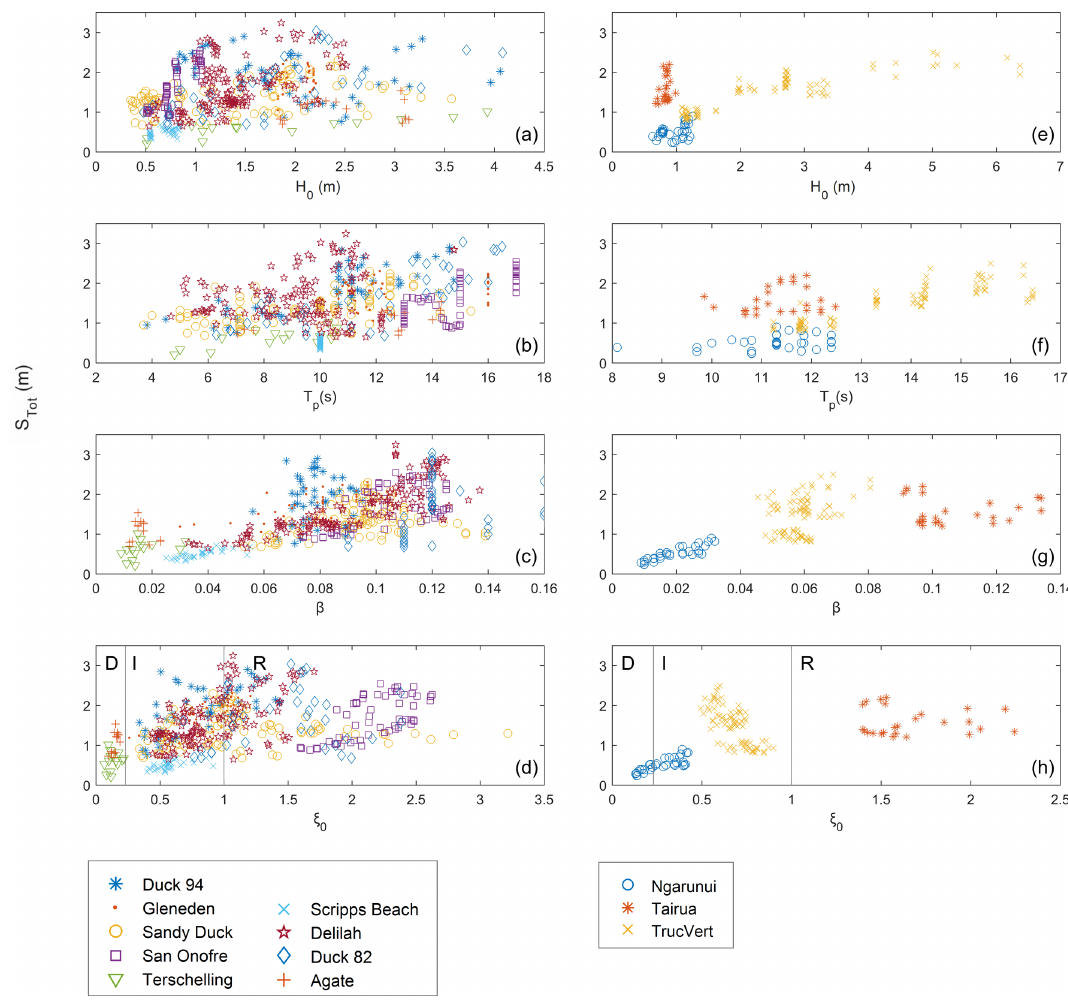
Figure 2. Total swash dependence on the environmental variables of the original (a, b, c, d) and new (e, f, g, h) data sets. The variables displayed are significant wave height (a, e) , wave peak period (b, f) , beach slope (c, g) and Iribarren number (d, h) . Beaches are considered dissipative (D) for values of ξ 0 <0.23, reflective (R) for ξ 0 >1 and intermediate (I) between the two (Short,